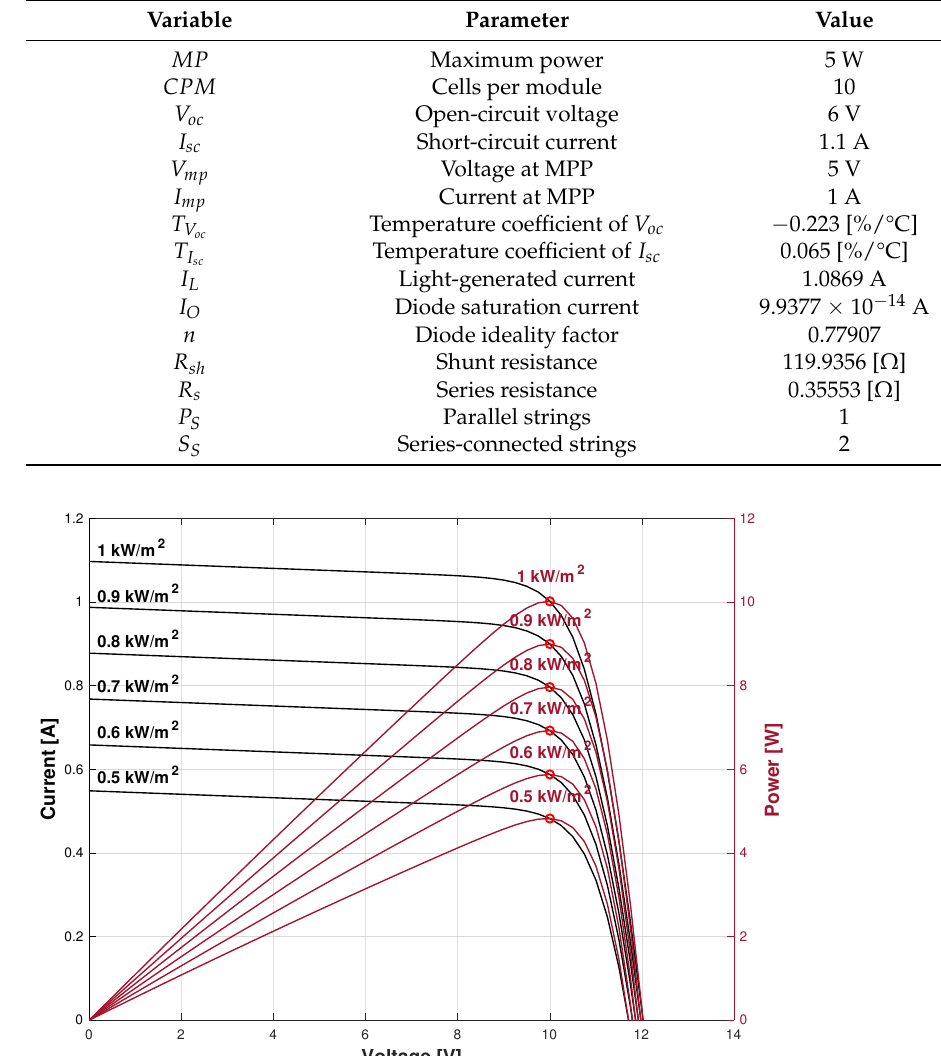
Figure 14. Current (black) and power (Red) against voltage feature profiles for the PV array from the experimental case